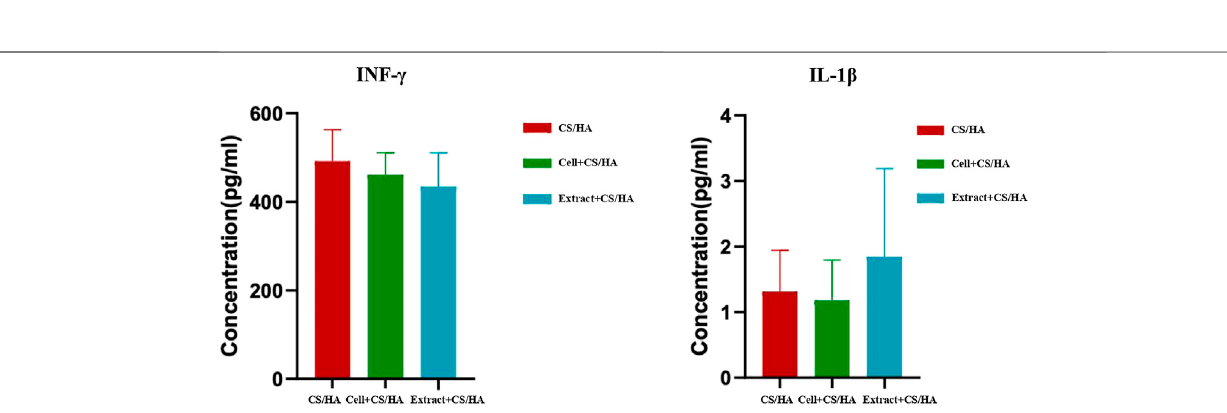
Frontiers in Bioengineering and Biotechnology |